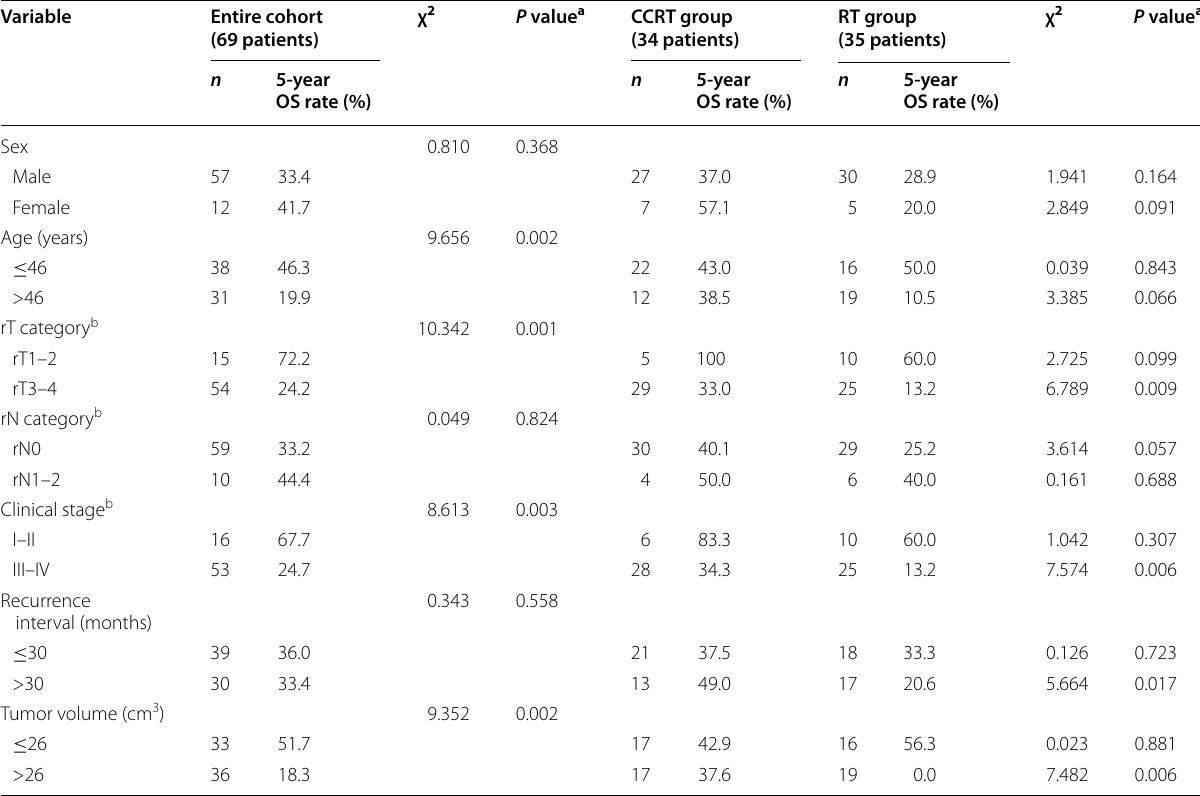
Abbreviations as in Table 1 a By log-rank test